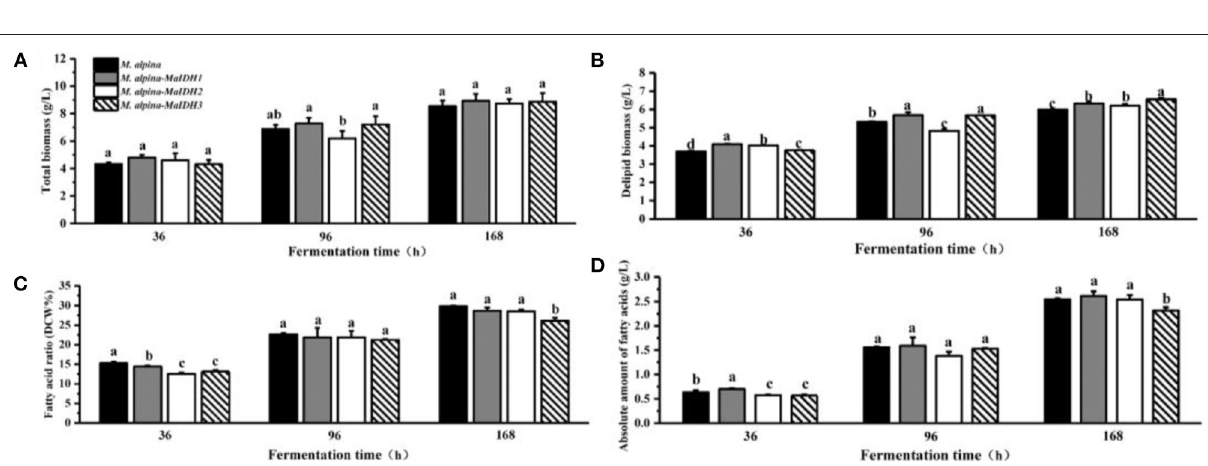
further research is needed to understand its impact on the biological